Question: Judging by this figure, is the value going up or going down?
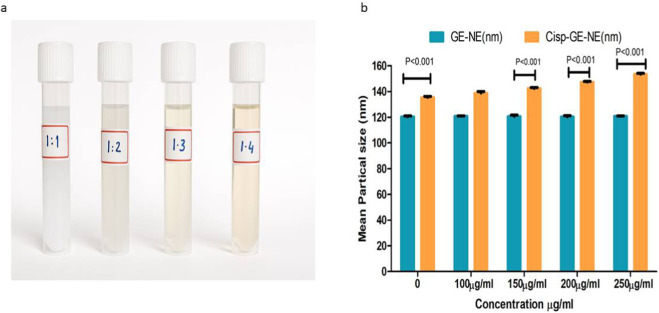
Answer: increasing